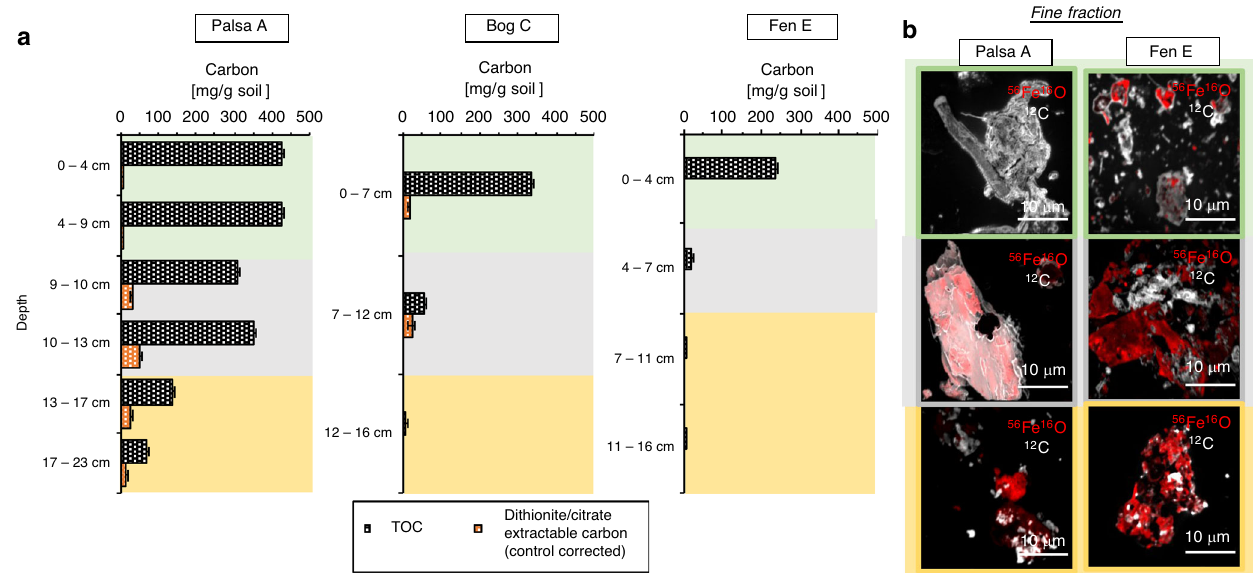
Fig. 4 Reactive Fe-bound organic carbon along the permafrost thaw gradient. Iron (Fe) and carbon (C) associations were determined along the thaw gradient by bulk ( b ) and fi ne fraction analysis ( a ). a Carbon bound by reactive iron minerals along the thaw gradient. The carbon which dislodged from the soil during the reductive dissolution of reactive iron oxides (orange) is shown in comparison to the total organic carbon determined via combustion (black grids, labeled as total organic carbon (TOC)). Dithionite – citrate extractable carbon is control-corrected by subtracting the measured dissolved organic carbon (DOC) content of a citrate solution and the measured DOC value from the sodium chloride (NaCl) control experiment. The NaCl control (same ionic strength and same pH as the sodium dithionite citrate extraction) shows negligible carbon release (Supplementary Table 1). Errors of the TOC indicate the range of duplicate analyses of each layer in each thaw stage. Errors of the dithionite/citrate extractable carbon (control corrected) represent a combined standard deviation of sodium chloride bicarbonate extractable OC, citrate blank, and dithionite/citrate extractable OC (not control corrected). b High spatial resolution analysis of iron – carbon associations by nanoSIMS along the thaw gradient (two end-members palsa (left) and fen (right)). The strong spatial association of carbon to iron (III) minerals could only be observed in the palsa transition zone. The other fi ne fractions showed organic-free iron minerals. For the two end-members palsa and fen, four particles of the fi ne fractions of each layer were analyzed by nanoSIMS, all showing the same spatial distribution of Fe and C as shown by these six representatives (see also Supplementary Fig. 11). The green background marks the organic horizon ( b , upper images), gray the transition zone ( b , middle images), and yellow the mineral horizon ( b , lower